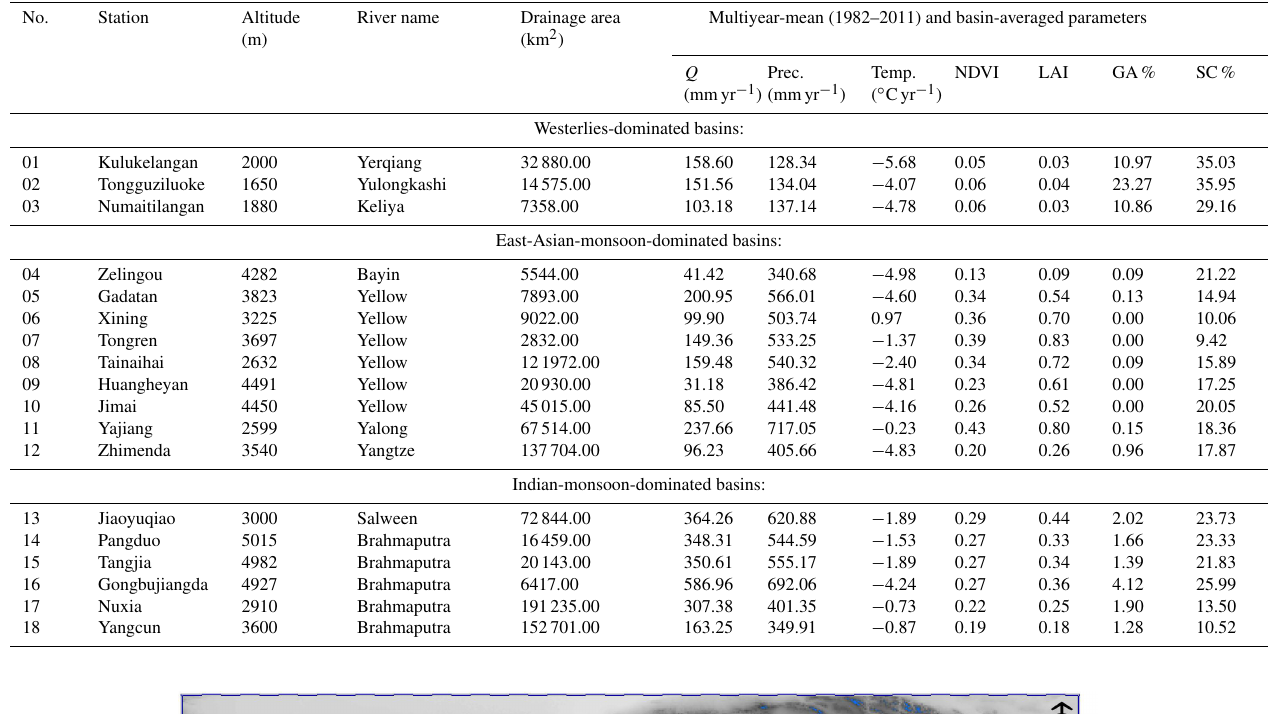
Table 2. Main features of the 18 TP river basins used in this study. The precipitation and temperature statistics for each basin were calculated from the observed CMA datasets while the NDVI and LAI statistics were extracted from the GIMMS NDVI dataset and GLASS LAI product. The GA and SC percentages represent the percentages of multiyear-mean glacier cover and snow cover in each basin, which were calculated from the second glacier inventory dataset of China and the daily TP snow composite products (2005–2013). No.